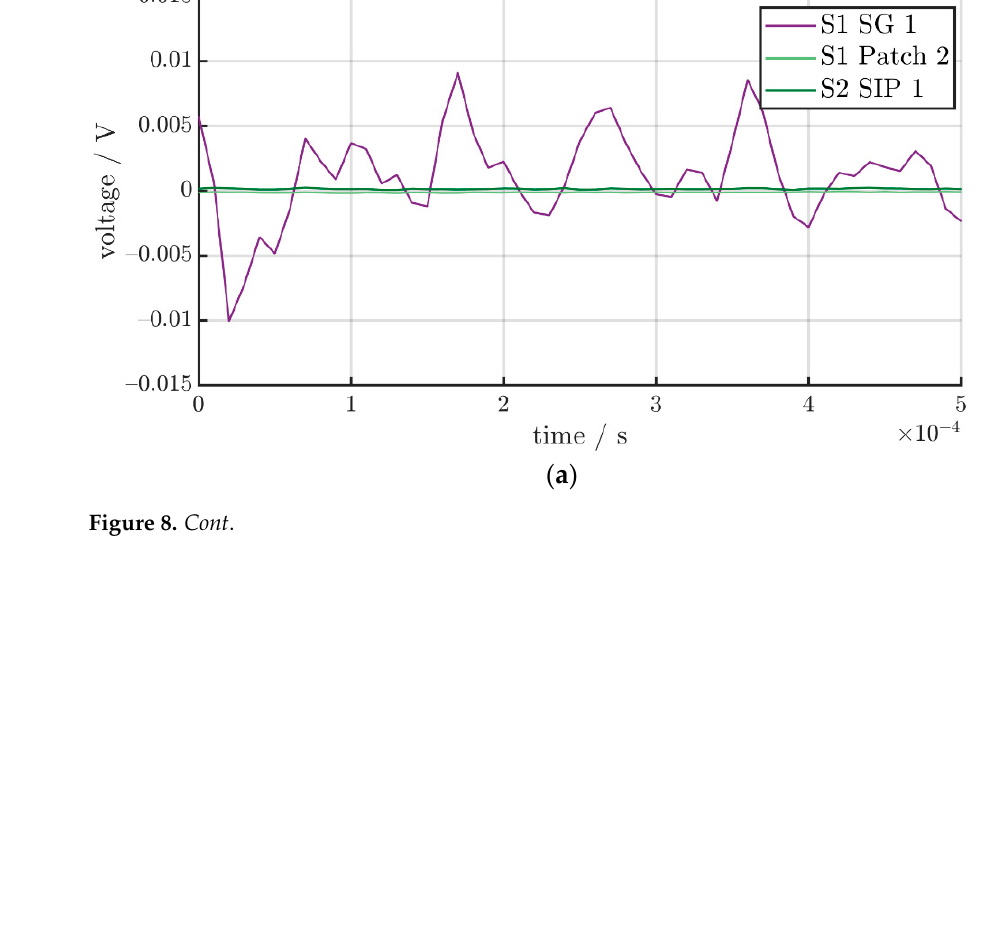
Table 5. Signal-to-noise ratios of the sensors.